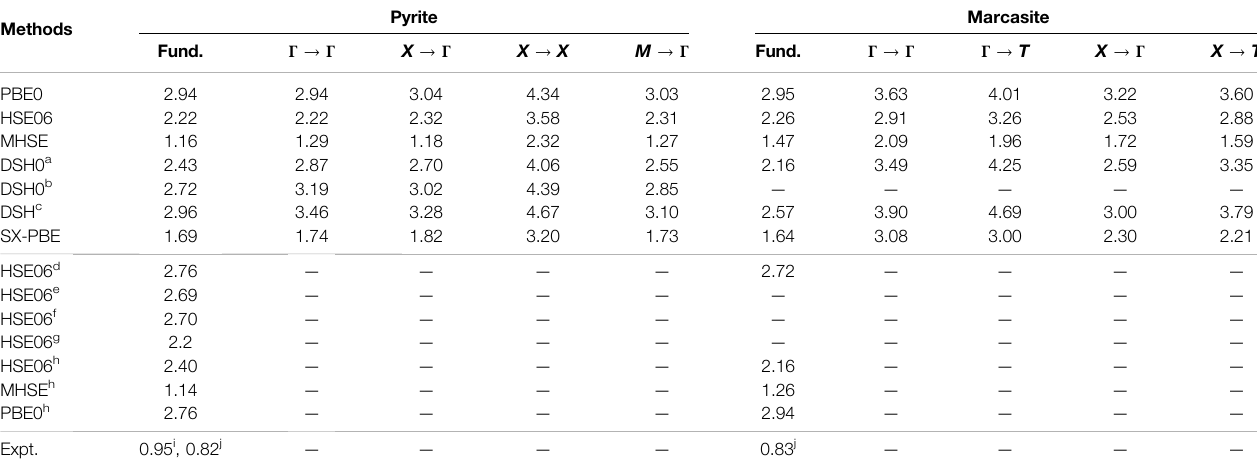
TABLE 3 | Fundamental band gap (indicated by “ fund. ” ) and other direct and indirect band gaps (unit: eV) for pyrite and marcasite FeS 2 calculated by different hybrid functionals. Results from other theoretical studies and experimental measurements are presented as comparison. Pyrite Marcasite Methods Fund.